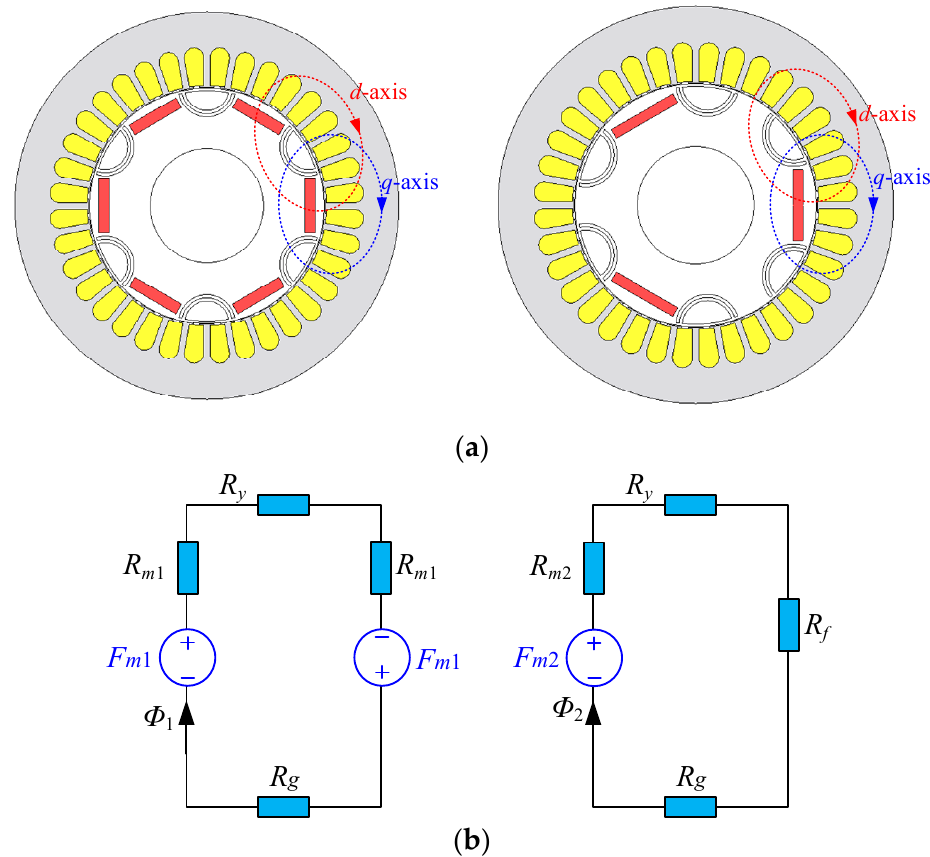
Figure 3. Magnetic circuits of FIMM and CP-FIMM, ( a ) d - and q -axis; ( b ) equivalent magnetic circuit of d